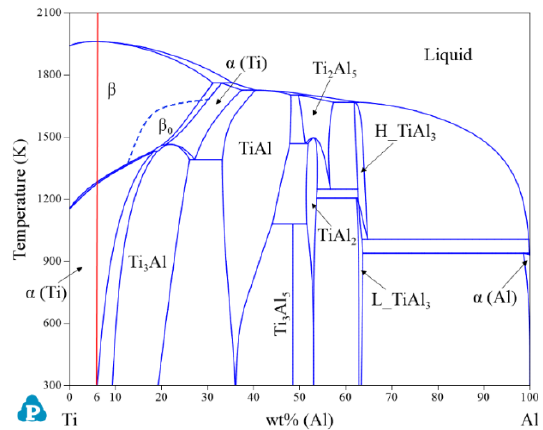
Figure 1. Calculated Ti-Al phase diagram using the thermodynamic parameters obtained by Witusiewicz et al. [18].